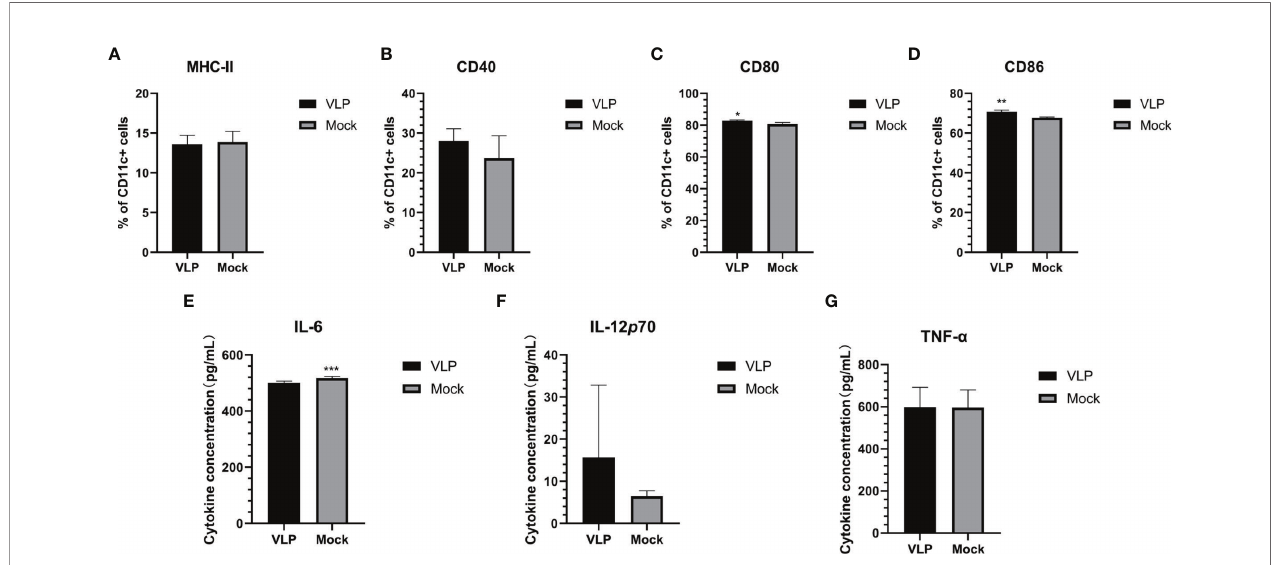
FIGURE 4 | Analysis of DC maturation in response to VLPs. Cultured DCs isolated from murine bone marrow were treated with PBS (Mock) or VLPs (10 m g) for 48 h respectively. Thereafter, fl ow cytometry was used to compare the percentages of CD11c+ DCs expressing MHC-II (A) , CD40 (B) , CD80 (C) and CD86 (D) . In parallel, culture supernatants were harvested to measure the secreted levels of IL-6 (E) , IL-12p70 (F) and TNF- a (G) . All experiments were performed independently at least thrice and results were presented as means ± standard deviation. Signi fi cance levels were de fi ned as *p < 0.05, **p < 0.01 and ***p <